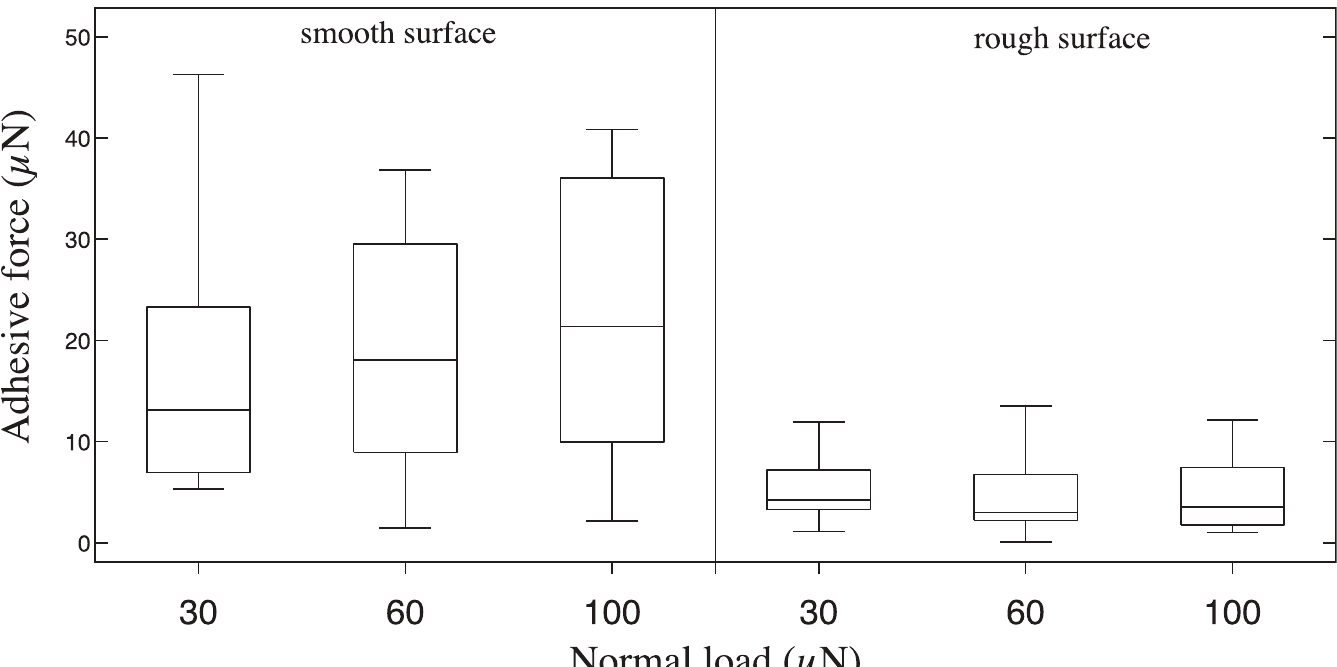
Fig 8. Adhesive forces of tarsal hairs on a smooth and rough surface (1 μ m asperity size) after pushing slides under different normal loads (30, 60 and 100 μ